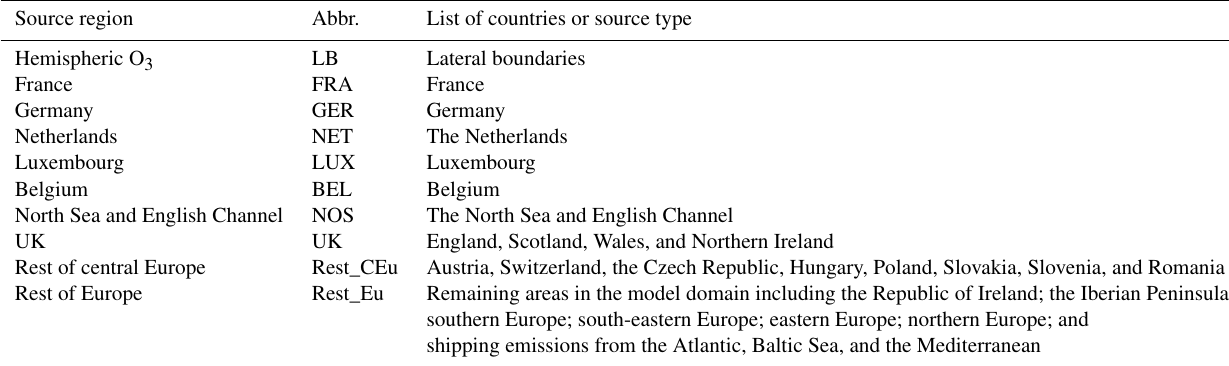
Table 2. List of tagged source regions. Source region